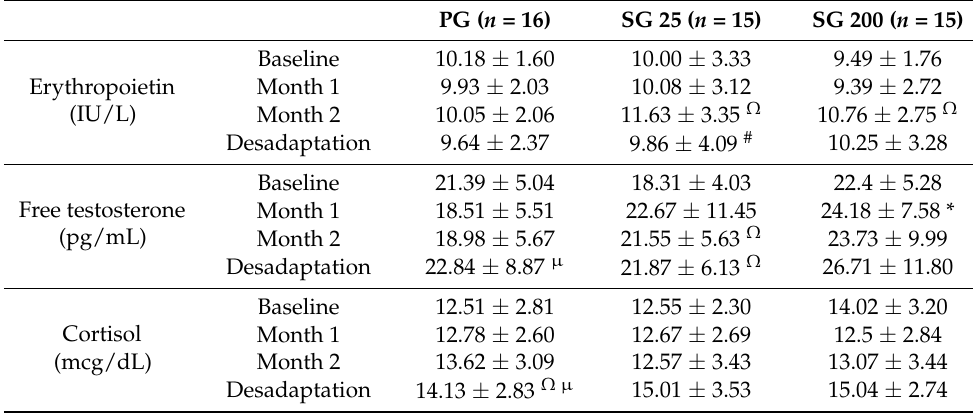
Table 4. Hormonal values at the